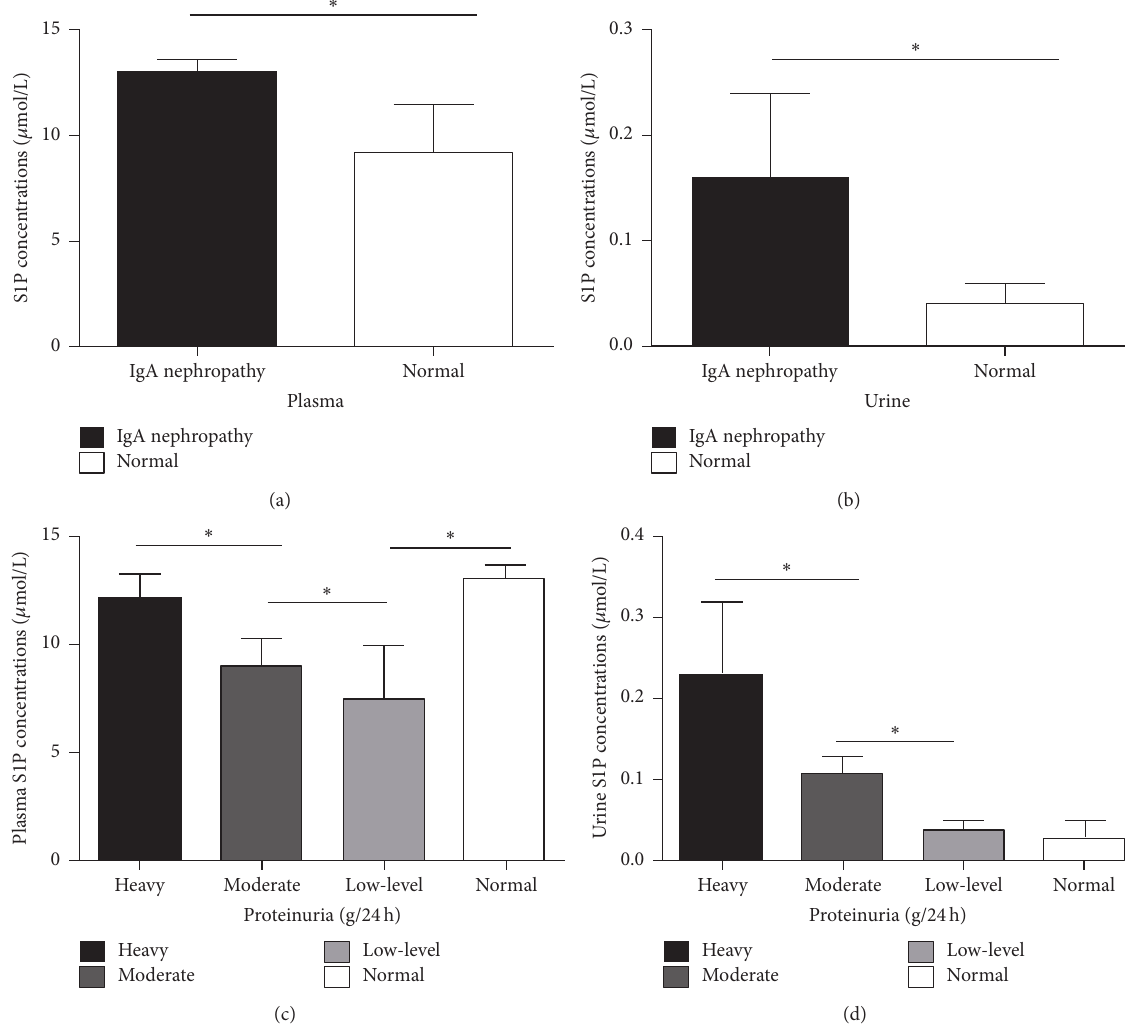
Figure 1: The concentration of S1P in serum and urine was positively correlated with chronic kidney disease renal injury. Forty IgA nephropathy patients and 10 healthy volunteers were selected. The 24 h urine and plasma were collected. Concentrations of S1P in plasma and urine were measured by using ELISA. (a) Concentrations of S1P in plasma in IgA nephropathy patients and healthy volunteers. (b) Concentrations of S1P in 24h urine in IgA nephropathy patients and healthy volunteers. (c) Concentrations of S1P in plasma in IgA nephropathy patients with different level of proteinuria and healthy volunteers. (d) Concentrations of S1P in 24 h urine from IgA nephropathy patients with different level of proteinuria and healthy volunteers. Data were expressed as means ± standard error of the mean from the independent sample in the same group. ∗ 𝑃 < 0.05 , versus normal group in (a) and (b). ∗ 𝑃 < 0.05 , versus heavy group or low-level group in (c) and